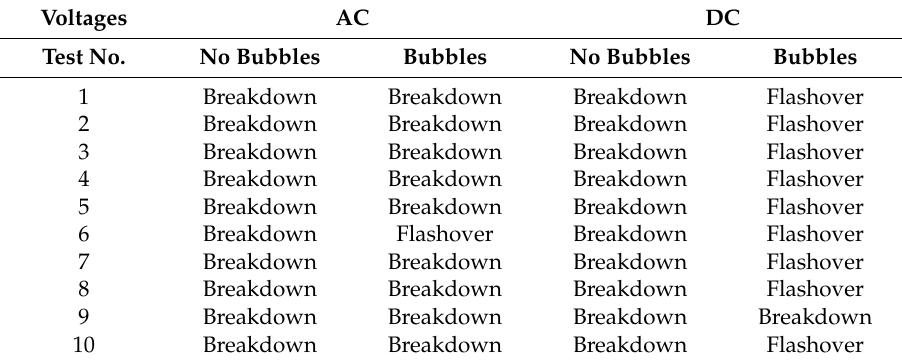
Table 5. The discharge forms of the oil-impregnated pressboard under AC and DC electric fields.